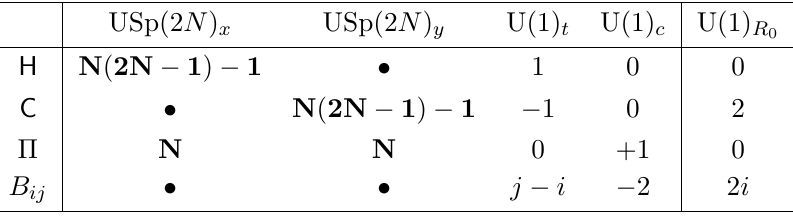
Table 2 . Trasnformation rules of the E [USp(2 N )]